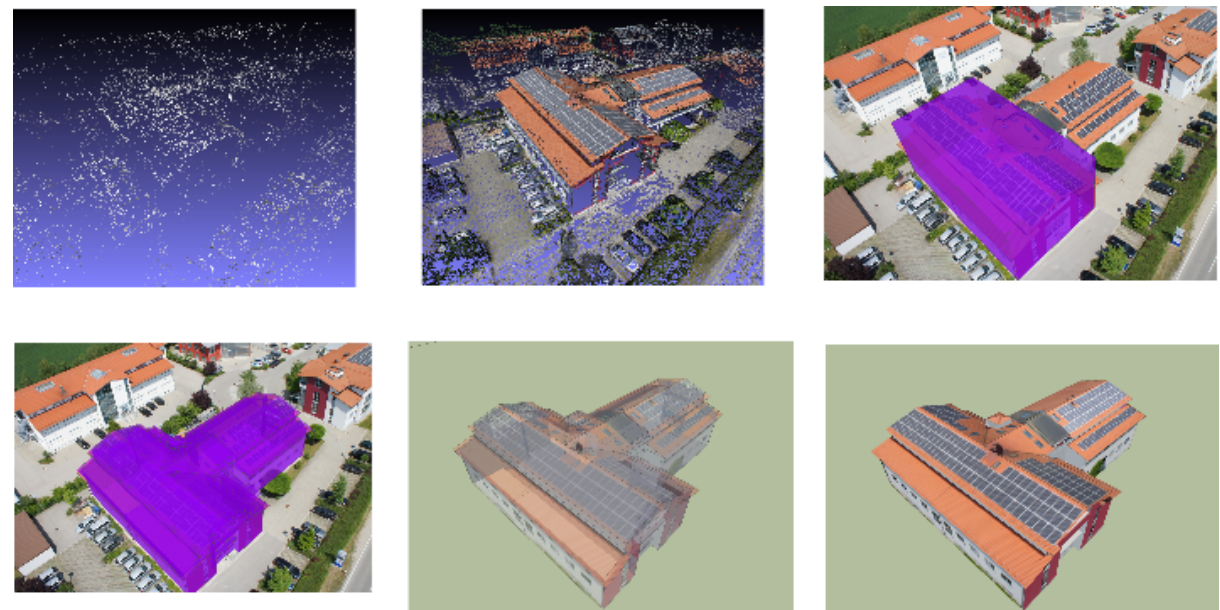
Figure 4: Main house dataset. From left to right, top to bottom: bundle block 3D points, dense matching colorized 3D points, box model on top of registered image, untextured 3D refined model on top of registered image, textured refined 3D model with translucid faces, textured refined 3D model